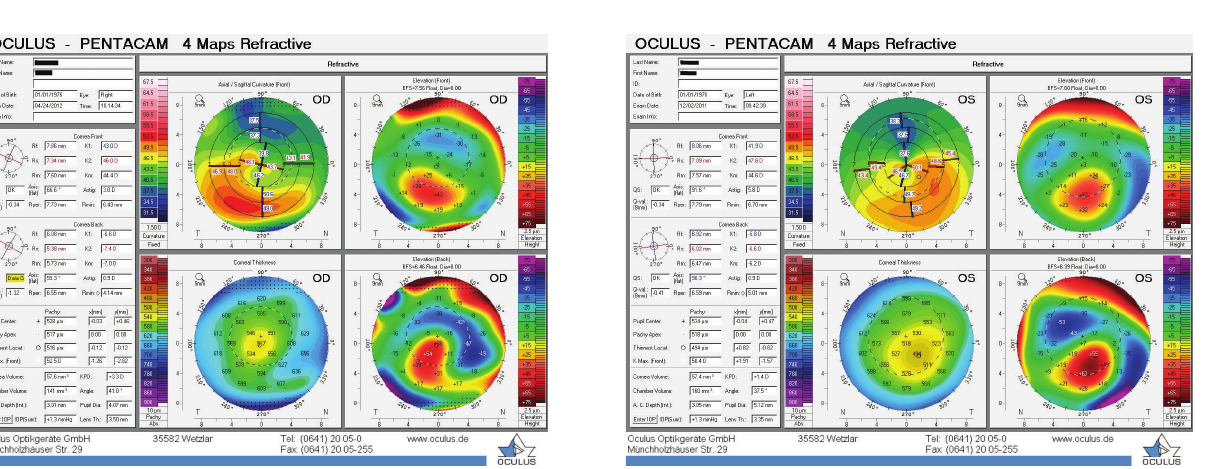
Figure 1: Patient 1, right eye before the treatment. Figure 2: Patient 1, left eye before the treatment.